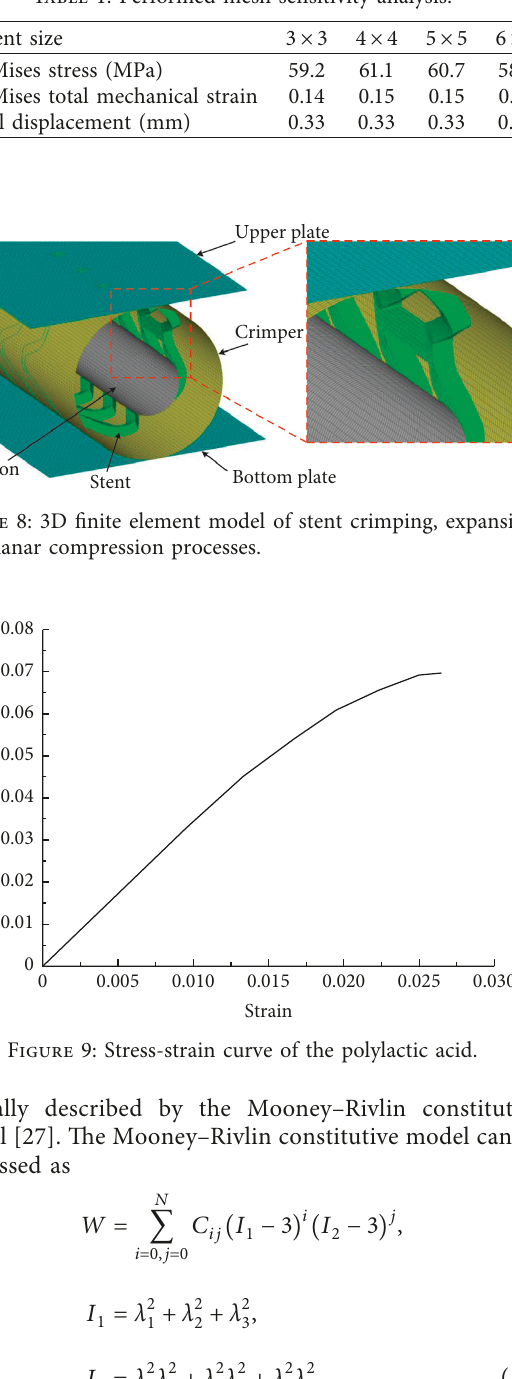
Table 1: Performed mesh sensitivity